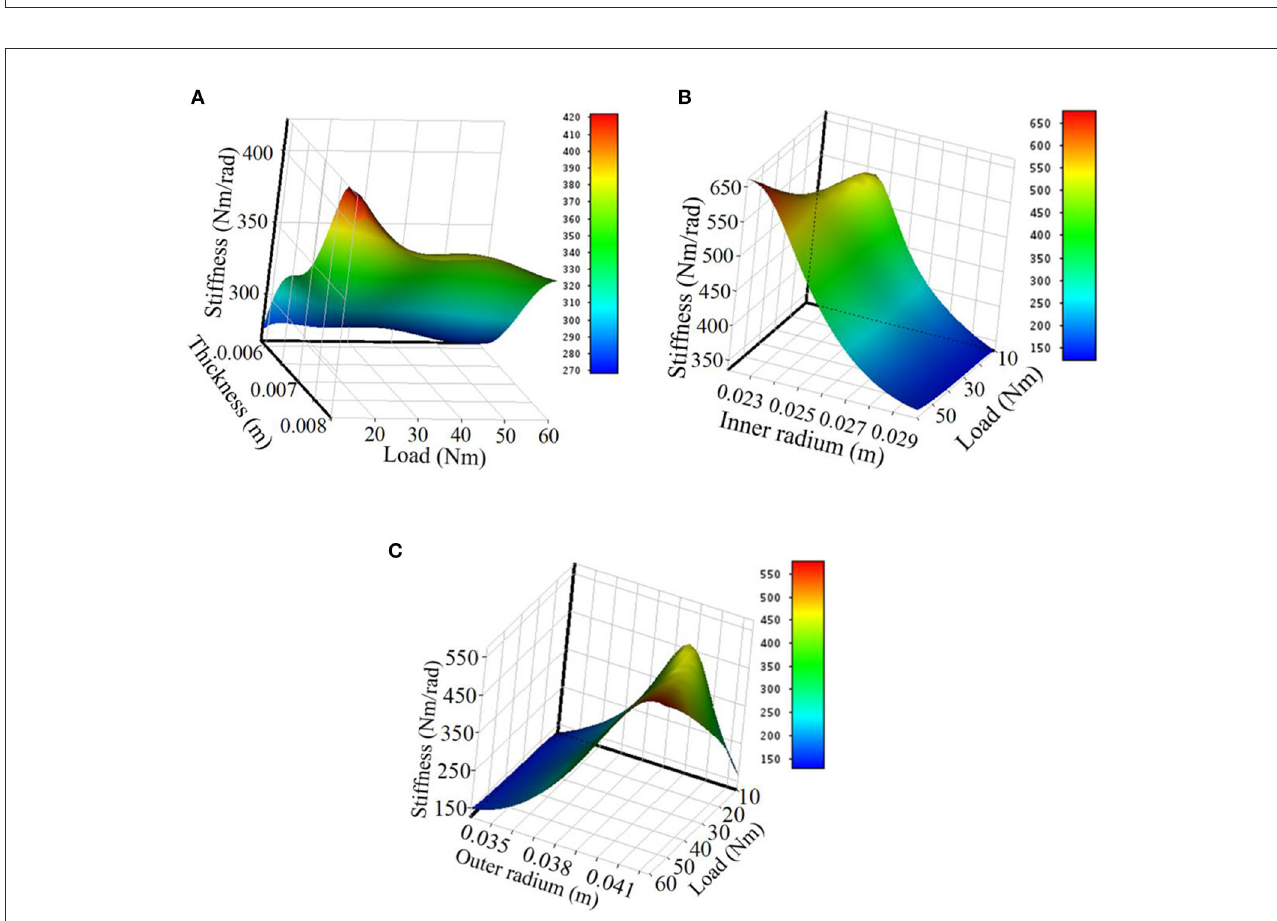
FIGURE4 The effects of the geometrical parameters on the stiffness. (A) Thickness effects on the stiffness. (B) Inner radium effects on the stiffness. (C) Outer radium effects on the stiffness.